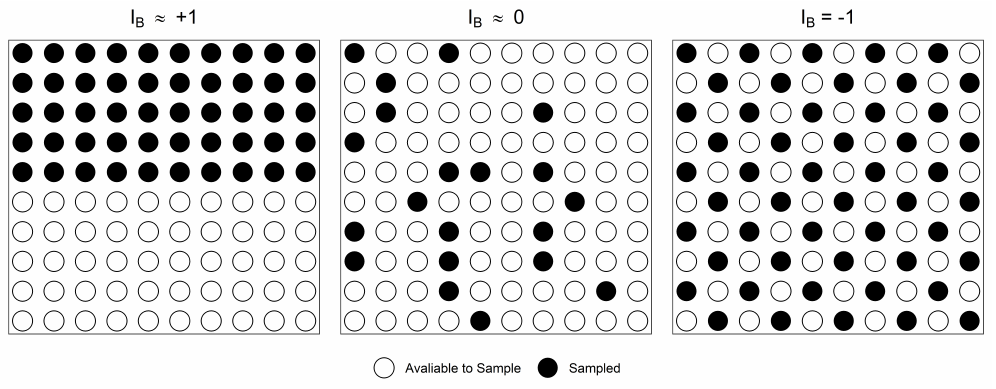
Figure 1. The Normalised Moran’s I Index ( I B ) takes the value of +1 for clustered samples ( left ), 0 for random samples ( centre ) and − 1 for spatially-balanced samples ( right